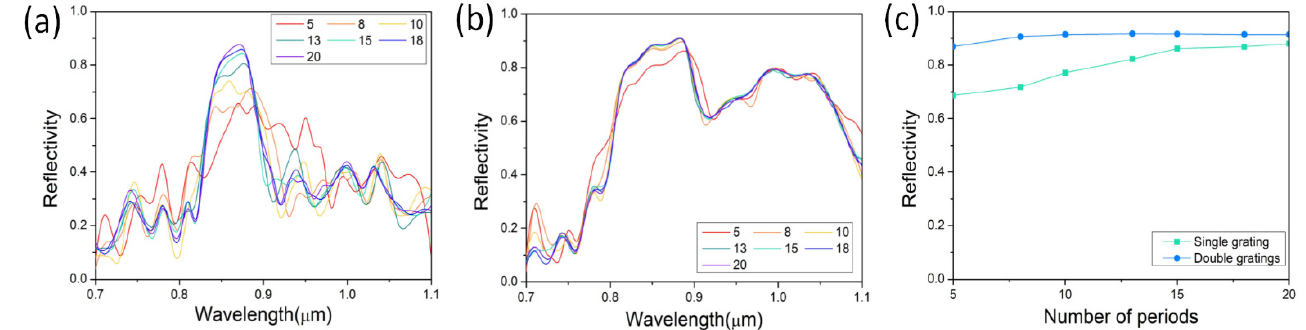
Figure 4. Reflective properties of gratings dependent on number of periods. Reflective spectra of var- ious number of periods for nanowire ( a ) on single grating and ( b ) sandwiched in double gratings. ( c ) Comparison of reflectivity between nanowire on single grating and sandwiched in double gratings.